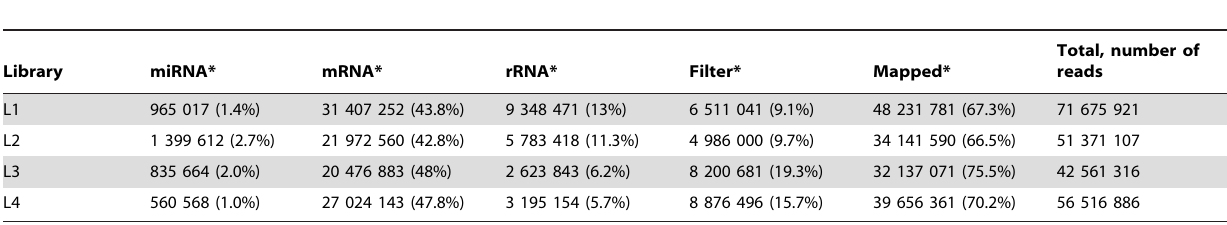
Table 1. Estimation of microRNA (miRNA) enrichment by mapping the sequencing data to the reference.